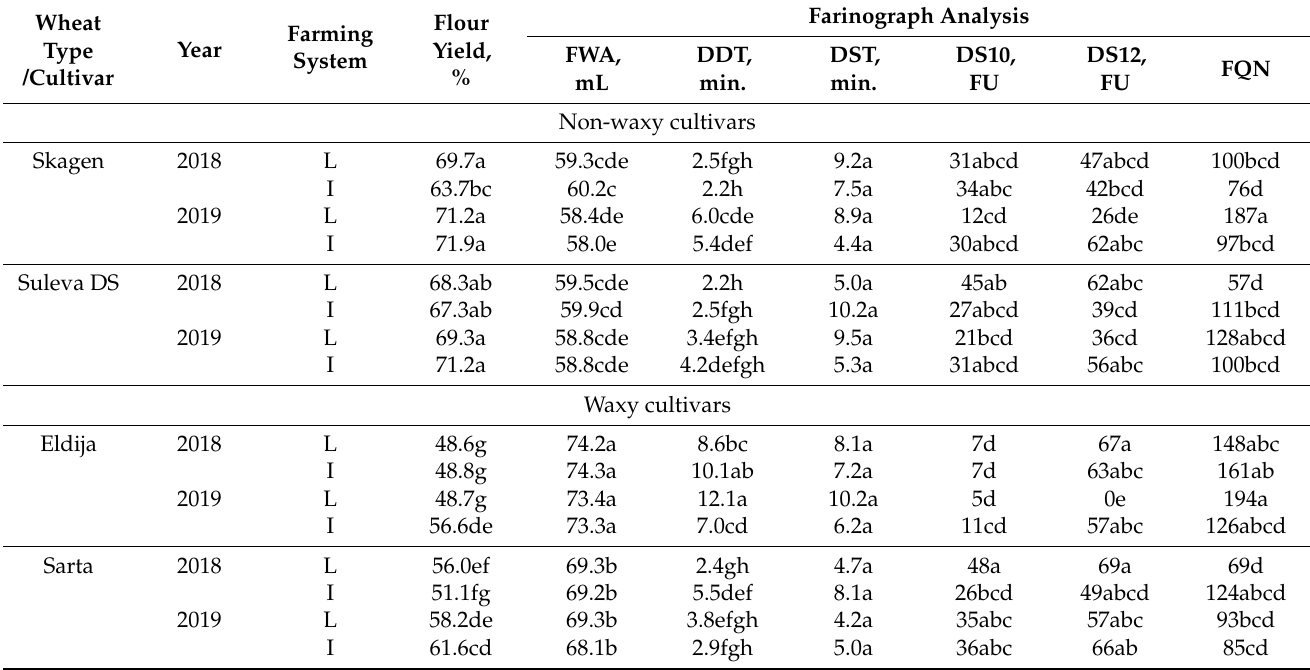
Table 2. Flour and dough quality characteristics of non-waxy and waxy winter wheat cultivars grown under different farming systems in two cropping seasons.